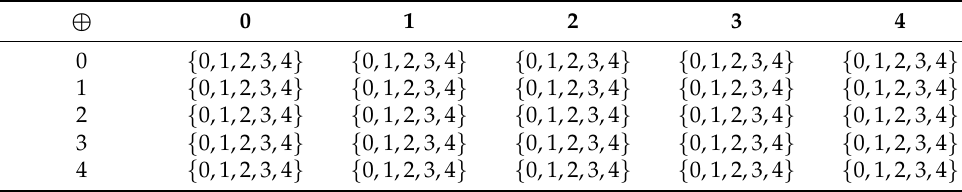
Table 14. Semihypergroup derived from Table 13.